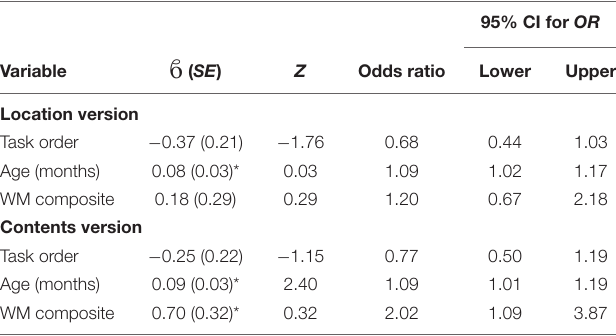
TABLE 6 | Ordinal logistic regression models for 3-option false belief tasks.